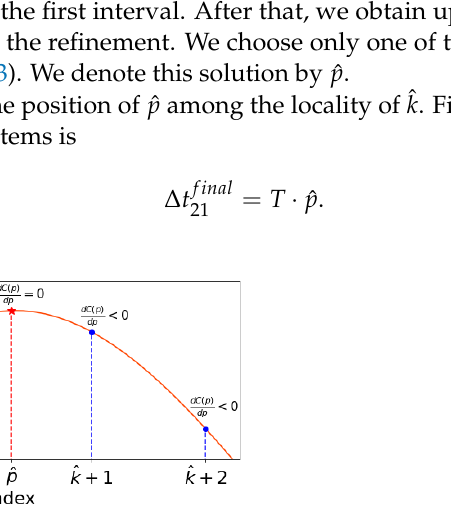
Figure 3. Cross-correlation and its interpolation by cubic spline in local area of ˆ k . Refinement ˆ p lies within the interval ( ˆ k , ˆ k + 1 ) in this